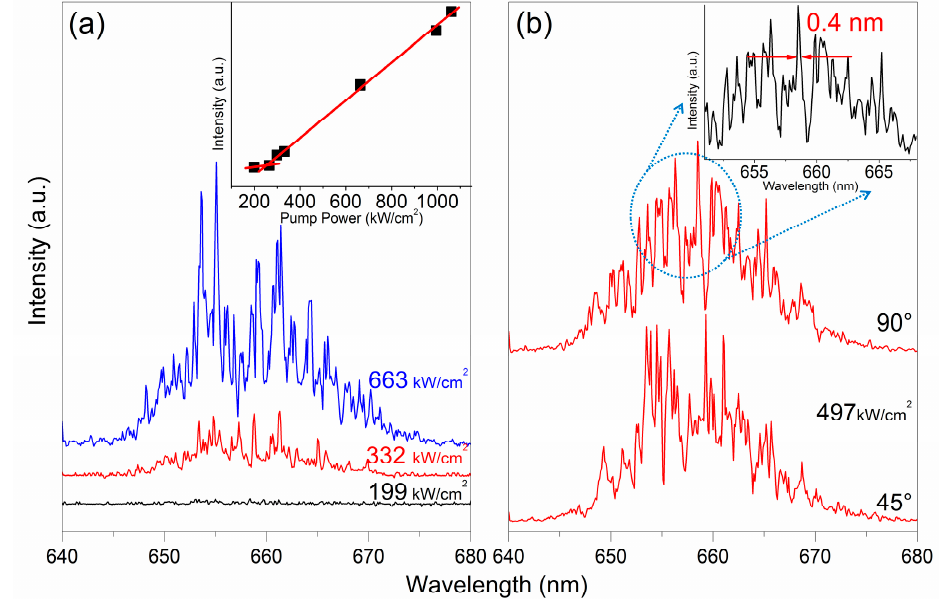
Figure 5. ( a ) Emission spectra of NaYF 4 :20%Yb,2%Er NCs film at around 660 nm wavelength versus different excitation power under 980 nm nanosecond laser excitation. The inset shows the corresponding input–output curve. ( b ) Emission spectra versus observation angle, θ . The inset shows the FWHM of the NaYF 4 :20%Yb,2%Er NCs laser.